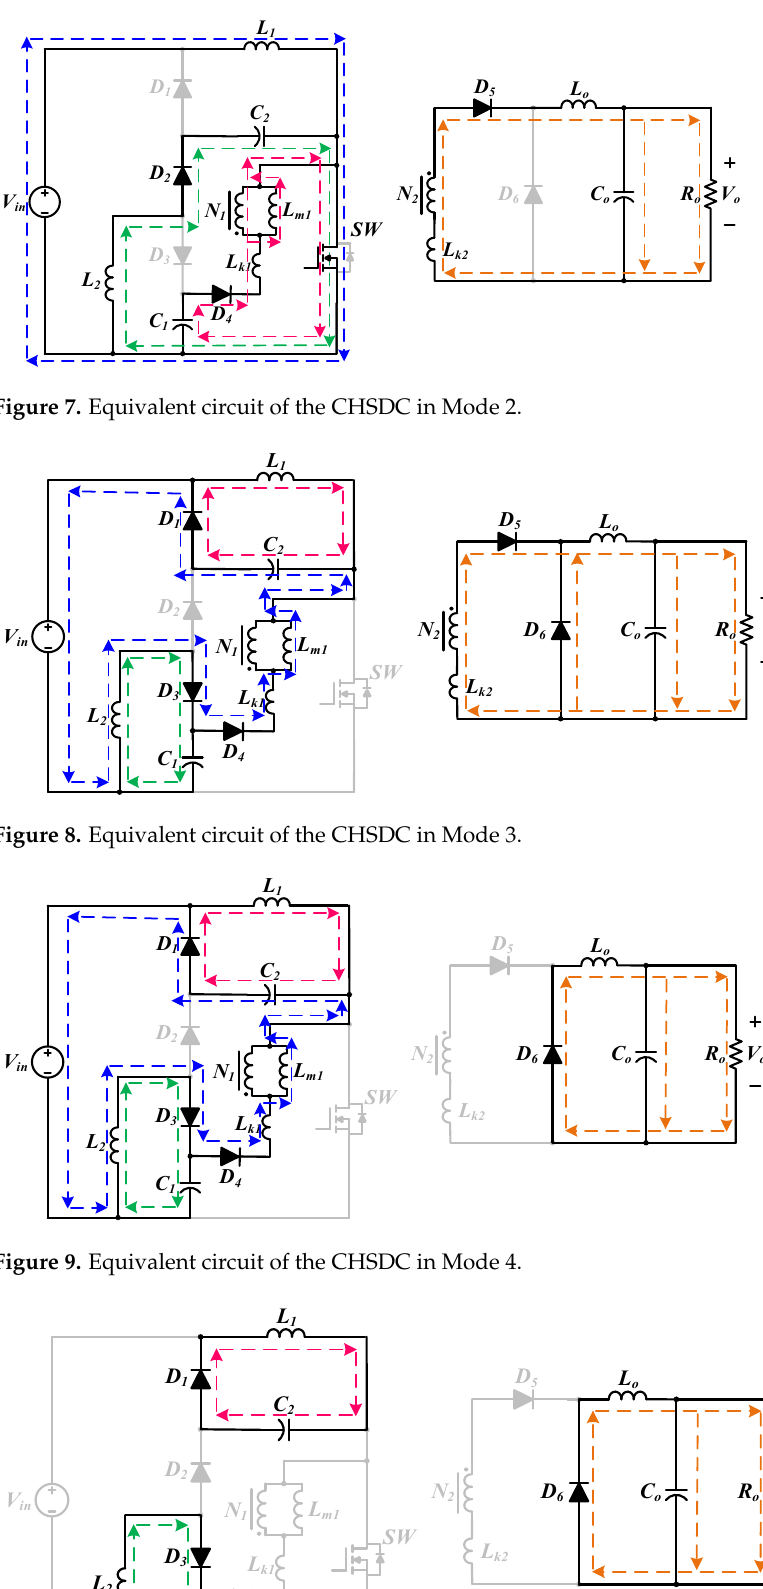
Figure 9. Equivalent circuit of the CHSDC in Mode 4. Figure 10. Equivalent circuit of the CHSDC in Mode 5. Figure 10. Equivalent circuit of the CHSDC in Mode